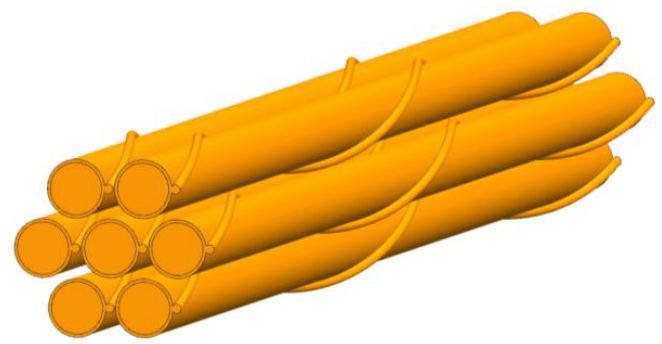
Figure 2. The wire-wrapped fuel bundle .